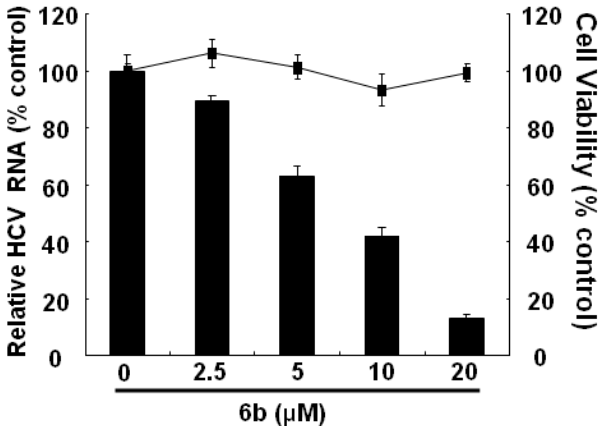
Figure 3. Inhibition of HCV RNA expression in HCV-infected Ava-5 cells by 6b . Ava-5 cells were treated with 2.5, 5, 10 and 20 µ M of 6b for 3 days. Total RNA was extracted and quantified HCV RNA levels by RT-qPCR. HCV RNA expression was normalized by cellular GAPDH mRNA. Treatment with 0.1% DMSO served as a mock control. The results are expressed as the means ± standard deviations (SD) of triplicate experiments.